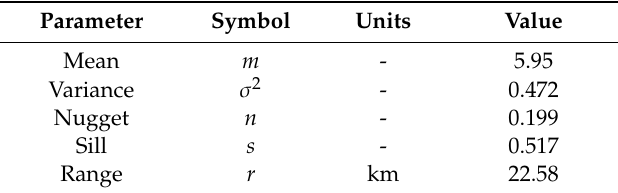
Figure 4. Cumulative frequency distribution of the estimated transmissivity and fitted log-normal distribution. Table 2. List of the estimated geostatistical parameters of the transmissivity of the Nubian sandstone aquifer in the Kharga oasis (the parameters refer to ln T , where T is given in m 2 / d).